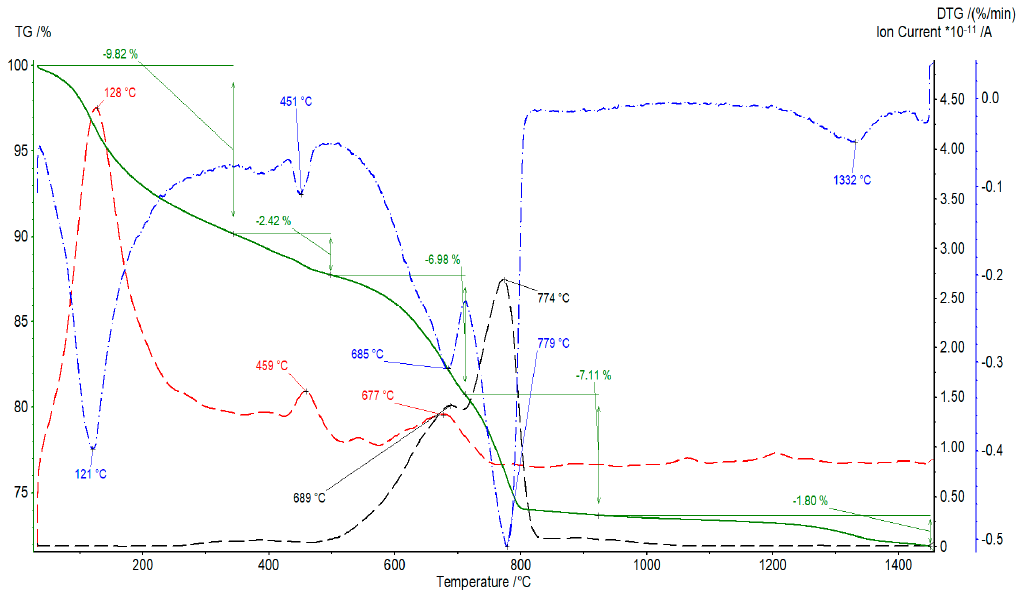
Figure 2. Thermo-gravimetric analysis (TG-DTG) results combined with evolved gas analysis (EGA) analysis (H 2 O—red line; CO 2 —black line) for a cement-asbestos waste board.